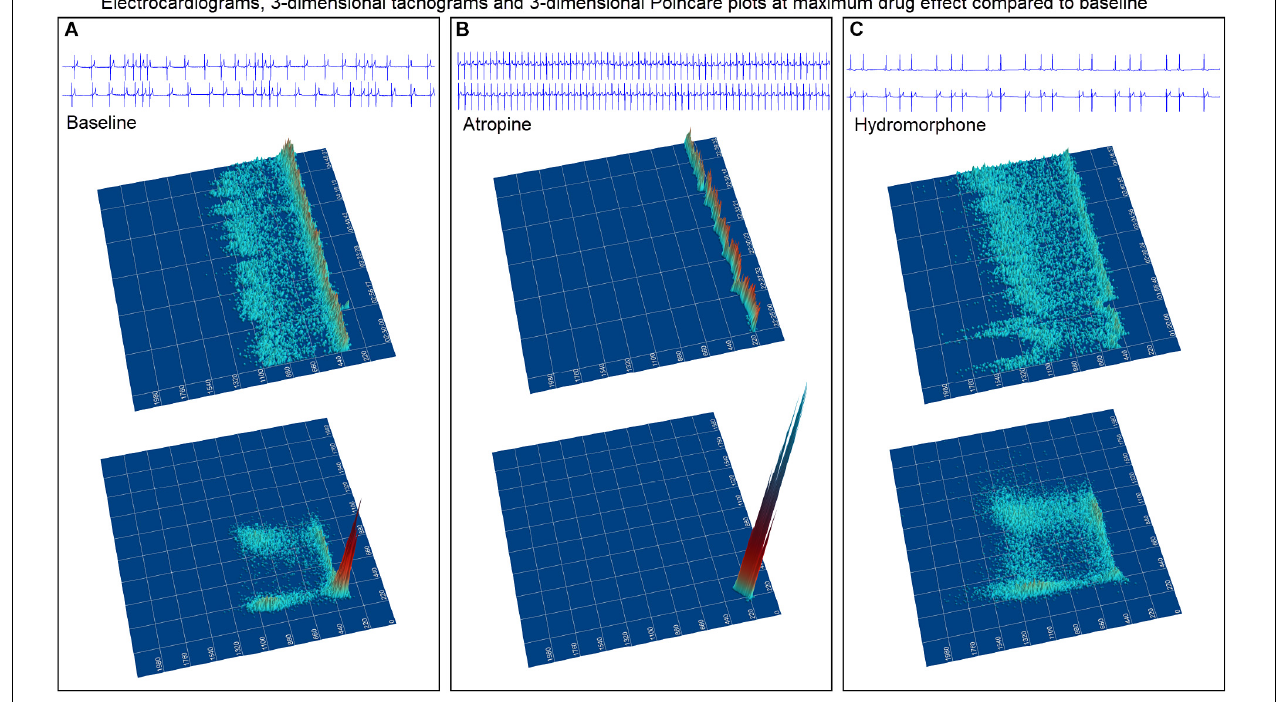
FIGURE 11 | The peak effects of atropine (0.04 mg/kg given intravenously) (Frame A ) and hydromorphone (0.2 mg/kg given intravenously) (Frame B ) compared to baseline (Frame C ) are shown in the electrocardiograms, three-dimensional tachograms and Poincaré plots of beagle 5. During the baseline recording the sinus arrhythmia has a pattern with a paucity of beat intervals that can be identified on both the tachogram and Poincaré plots. At the longest intervals a cloud appears near the line of identity. After the administration of atropine (Frame B ) that results in a decrease in parasympathetic modulation, the heart rate not only increases with a loss of sinus arrhythmia but the pattern of beat-to-beat intervals becomes linear. After the administration of hydromorphone (Frame C ) that results in an increase in parasympathetic modulation, the heart rate slows and the bifurcation interval increases with a paucity of beat intervals (zone of avoidance). Scaling of all images is the same to show